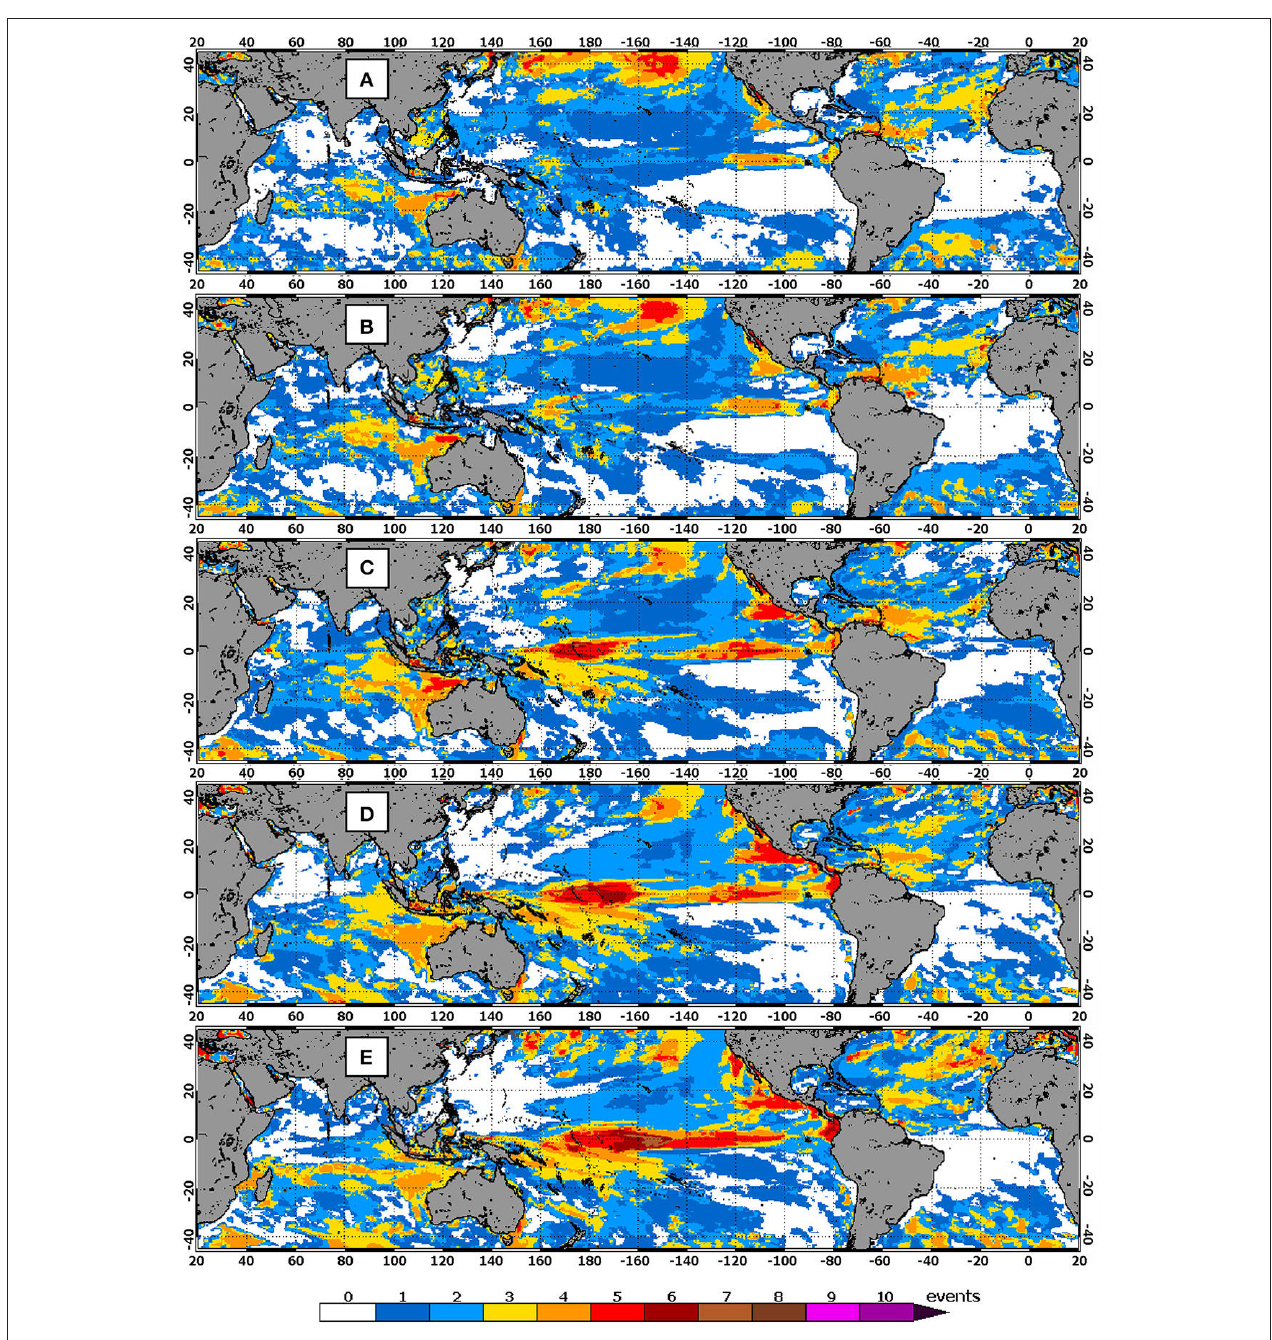
FIGURE 5 | Numbers of bleaching events identified by CRW’s weekly Outlooks (Version 3) of 60% probability during the comparison time period of August 1, 2011–December 27, 2015 for lead-times of: (A) 3-weeks, (B) 5-weeks, (C) 9-weeks, (D) 13-weeks, and (E) 17-weeks.